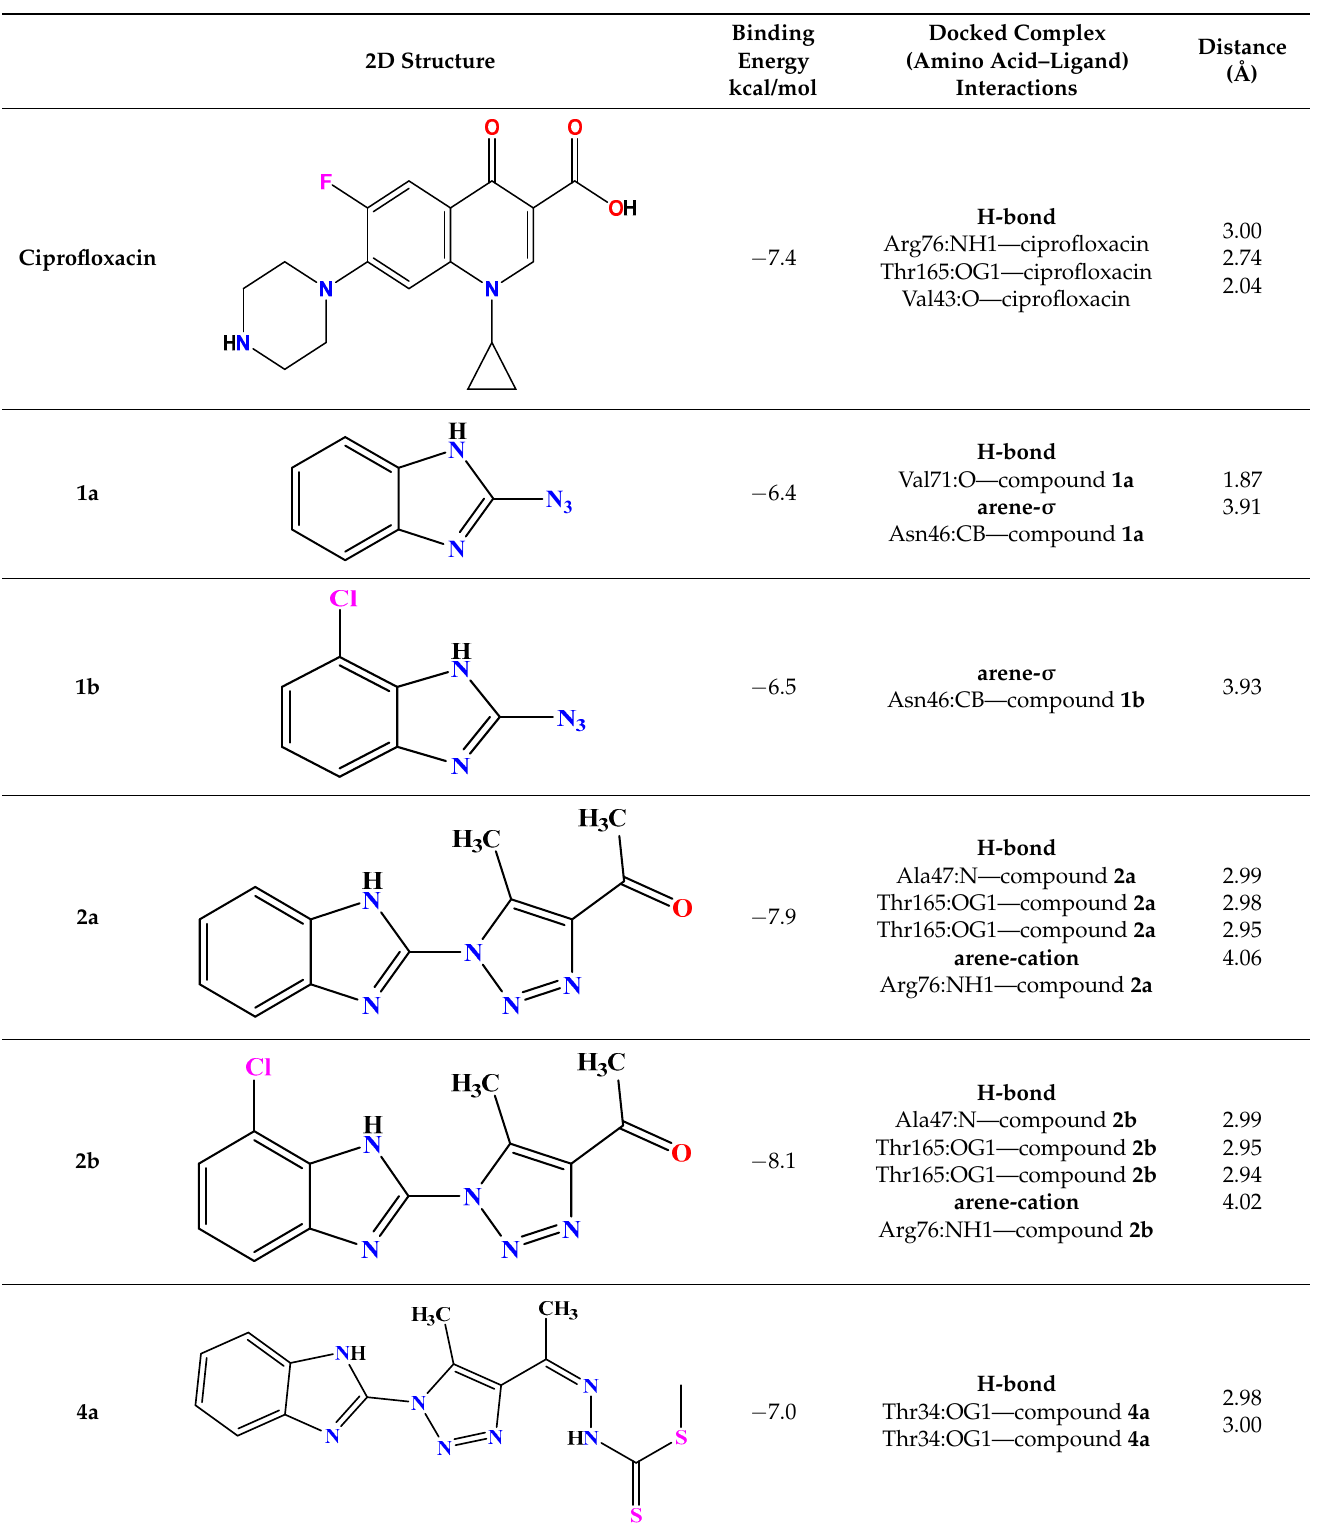
Table 1. Energy-based interactions and intermolecular bindings between the prepared compounds and the target enzyme.